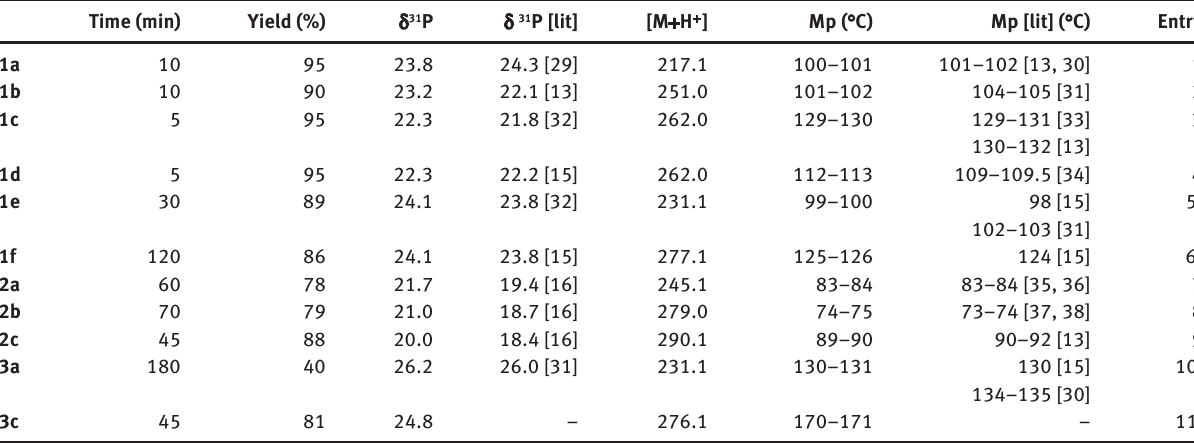
Table 2: Experimental details for the preparation of α -hydroxyphosphonates ( 1 , 2 , and 3 ). Time (min) Yield (%) δ 31 P